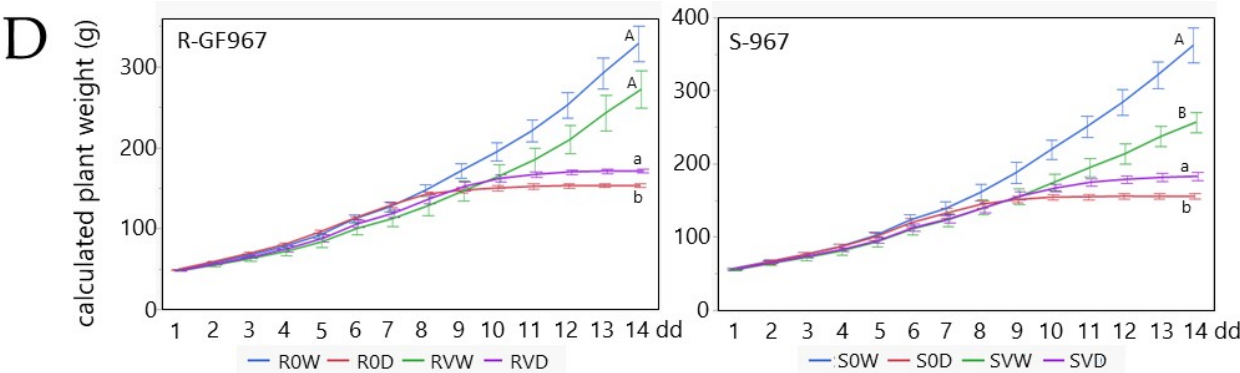
Figure 3. Water balance in S-967 and R-GF967 plants exposed to drought stress depends on virus infection. Using the Plantarray system, physiological parameters were measured over 14 days for uninfected normally irrigated R-GF967 (R0W) and drought-exposed (R0D) tomatoes; the same conditions were analyzed for TYLCV-infected R-GF967 plants (RVW vs. RVD). S-967 tomatoes were coined as S0W-S0D and SVW-SVD. ( A) Efficiency of daily transpiration expressed as delta of plant mass (g) in morning and evening. Mean ± SE continuous daily whole plant transpiration during the entire experimental period. ( B) Normalized transpiration (E). Mean ± SE midday transpiration rate normalized to weight (E) during the entire experimental period between 11 am and 1 pm. ( C ) Physiological drought point ( Θ crit ) and water use efficiency (WUE). Θ crit was identified as midday transpiration rate vs. the soil water content (SWC crit ) of tomatoes grown in water withholding conditions. WUE is identified as the ratio between the gain of daily weight and the daily transpiration. Mean ± SE of WUE calculated automatically by SPAC analytics software; values with same letter are not significant ( p = 0.05, Student’s t -test). ( D ) Calculated plant weight (CPW) determined as the sum of the initial plant weight (calculated before growth in SPAC-Analytics) with the cumulative transpiration multiplied by WUE. Mean ± SE of CPW for the entire experimental period. Values with deferent letters are significant ( p < 0.05, Student’s t -test was carried out separately for normally irrigated and drought on 14 dd).